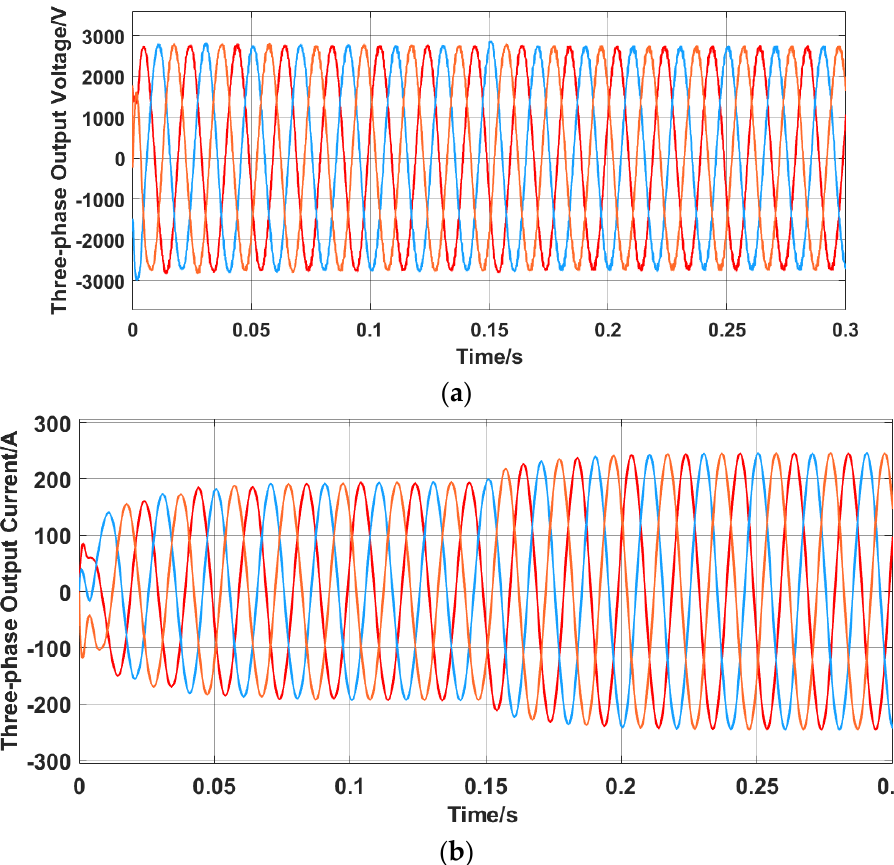
Figure 7. ( a ) Three − phase output voltage. ( b ) Three − phase output current.